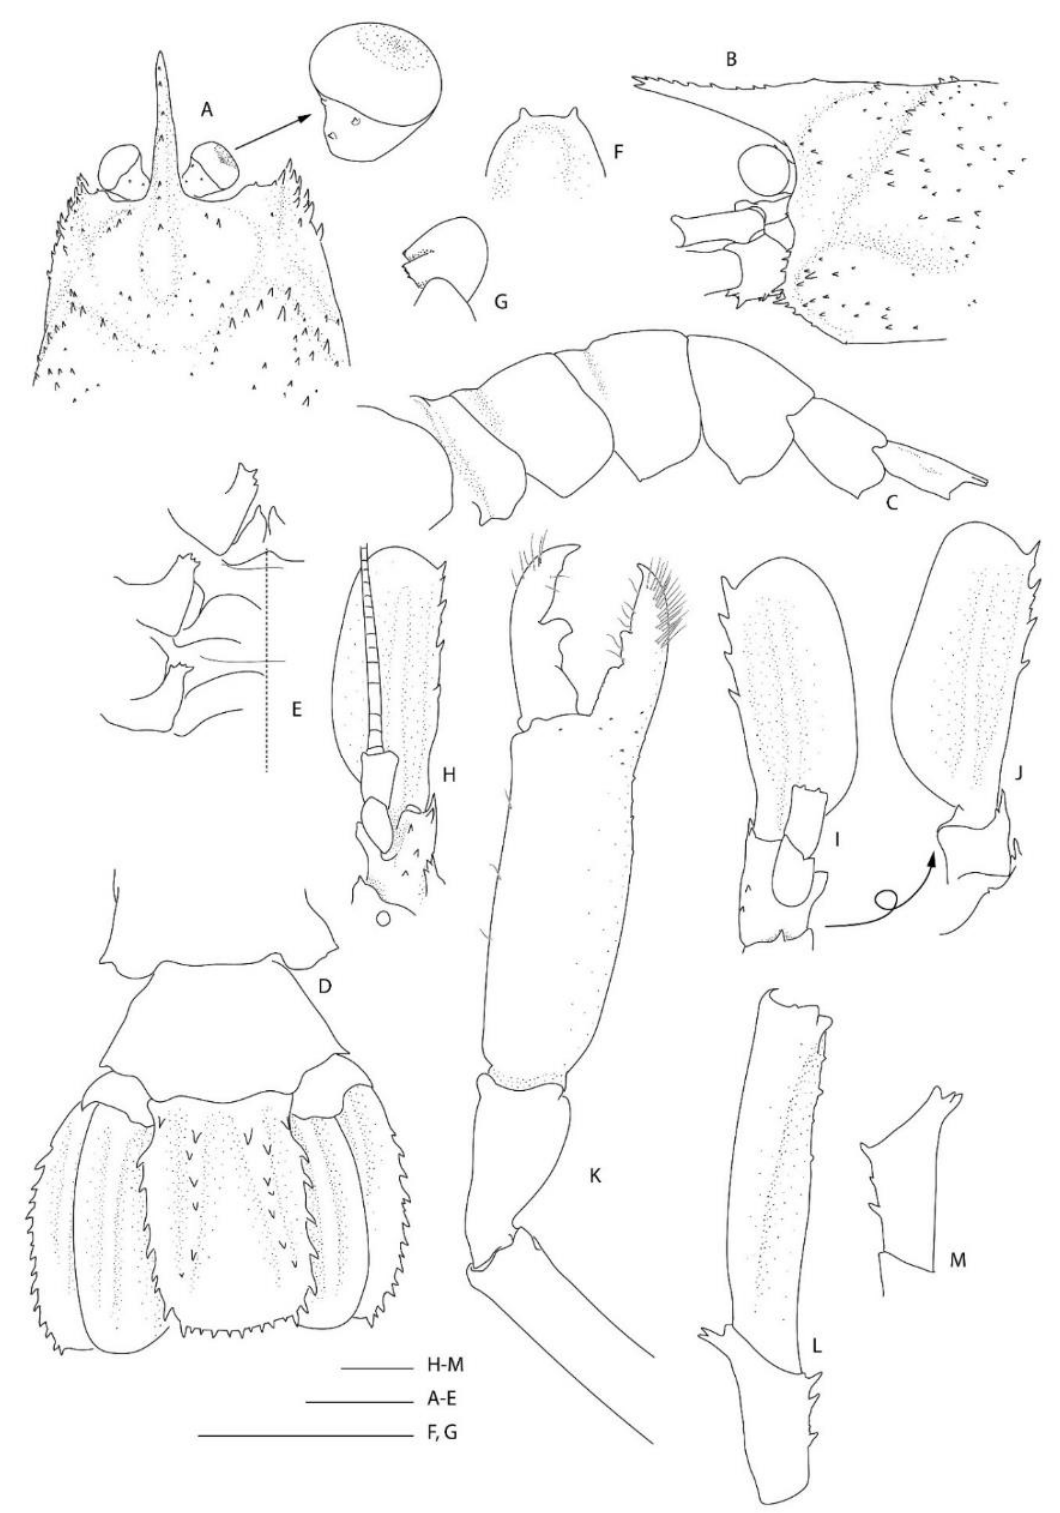
Figure 14. Spongicoloides sonne sp. nov., allotype M (NIWA 127110). ( A ) Anterior carapace, dorsal, with inset of enlarged right ocular peduncle. ( B ) anterior carapace and cephalic appendages, lateral. ( C ) Pleon, lateral. ( D ) Pleonites 5–6, urosome and telson, dorsal. ( E ) Thoracic sternites 6–8 with coxae of pereiopods, ventral. ( F ) Anterior margin of epistome, ventral. ( G ) Left mandible with paragnath, outer view. ( H ) Left antennae, ventral. ( I ) Right antenna, ventral. ( J ) Right antenna, dorsal. ( K ) Distal P3, lateral, right. ( L ) Proximal P3, lateral, right. ( M ) P3 ischium, left, lateral. Scale bars = 2 mm.